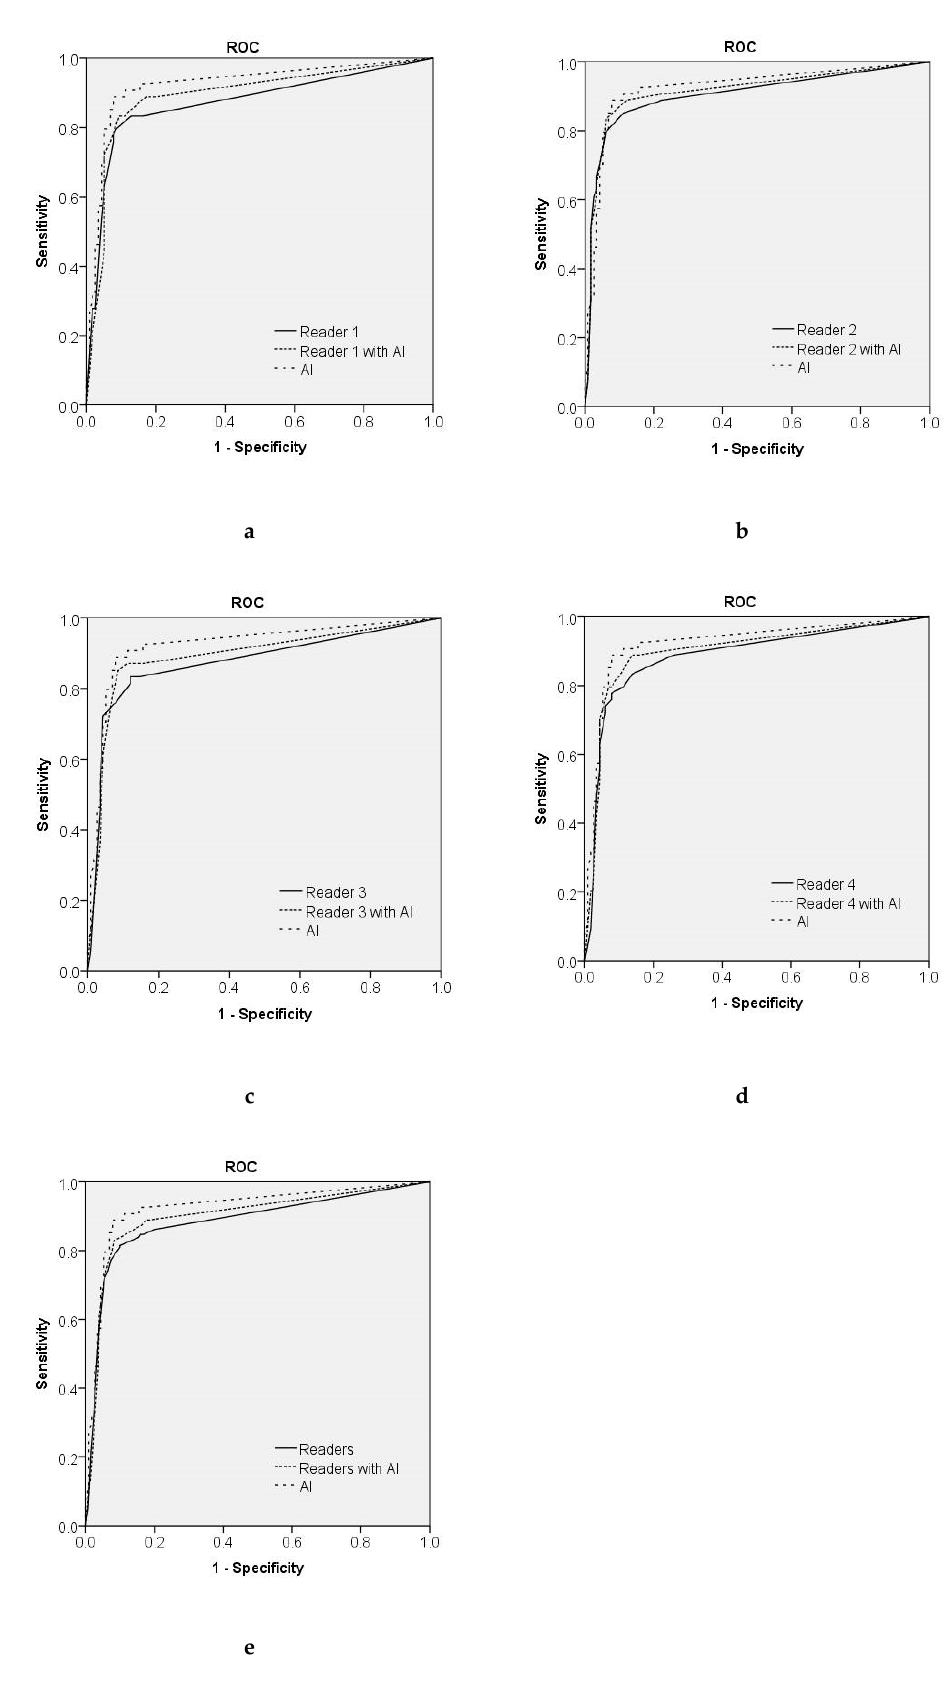
Figure 4. The ROC curve for the AI system compared with that of each human reader ( a – d ) and all four human readers ( e ). The AUCs of the human readers without the AI system were 0.872–0.904, and those of each human reader with the AI system were 0.893–0.915. The AUCs of the AI system, all four